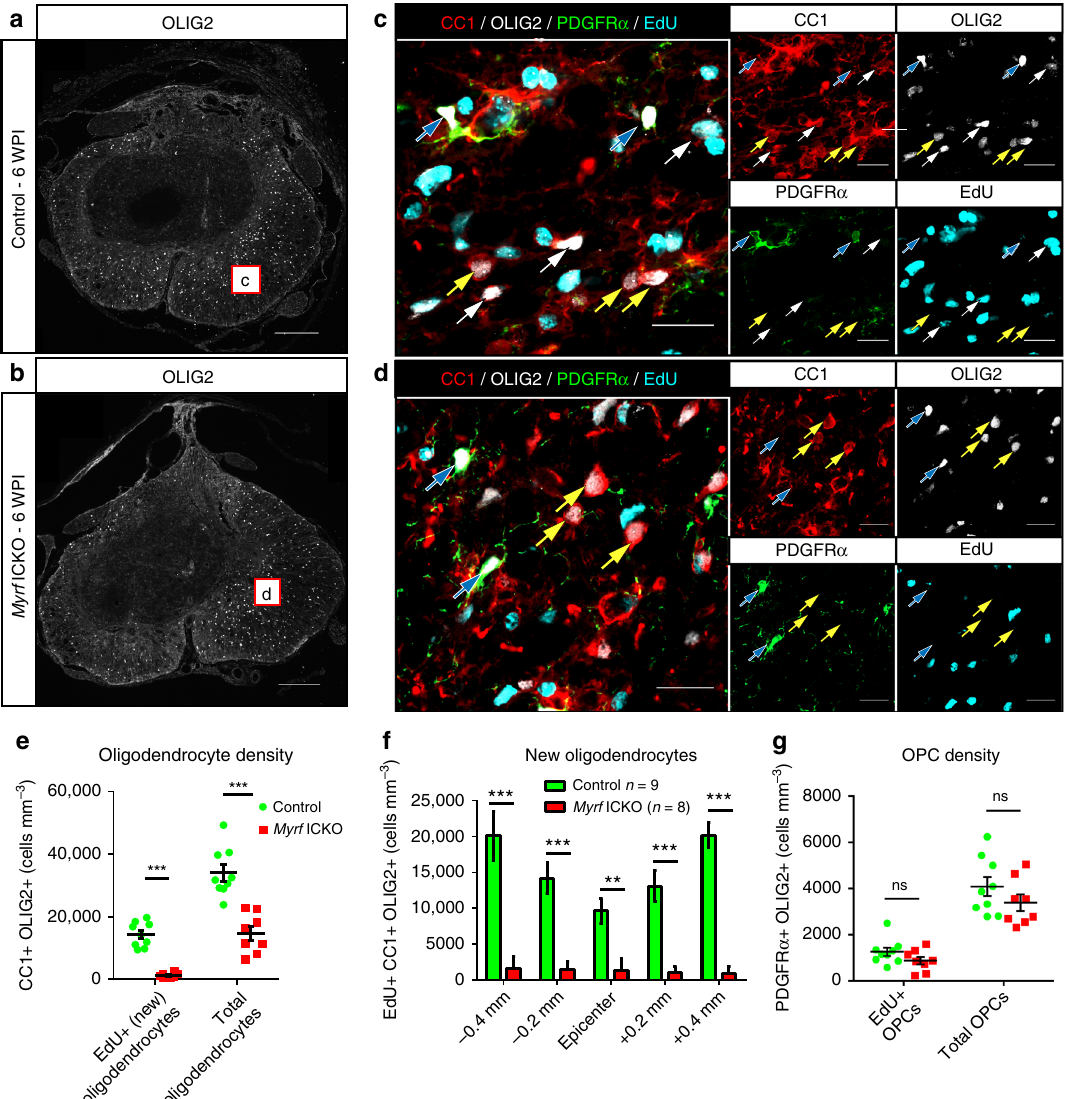
Fig. 2 Myrf ICKO mice generate few new oligodendrocytes in response to SCI. Overview of OLIG2 staining at injury epicenter in a control and b Myrf ICKO mice at six WPI. Boxes are approximate areas where c and d were imaged. c , d Example high magni fi cation representative images of the ventrolateral white matter stained with PDGFR α , OLIG2, CC1, and EdU in control and Myrf ICKO mice. Single channel images are displayed separately on the right. Yellow arrows indicate oligodendrocytes lacking EdU (OLIG2 + CC1 + EdU-negative), which are likely spared oligodendrocytes, while white arrows indicate new oligodendrocytes (OLIG2 + CC1 + EdU + ) and blue arrows indicate OPCs (OLIG2 + PDGFR α + EdU±). There are very few new oligodendrocytes following SCI in Myrf ICKO. e Quanti fi cation demonstrates control mice have a higher density of new oligodendrocytes (CC1 + OLIG2 + EdU + ) ( df = 15, t = 9.224, P < 0.001, Student ’ s t test) and total oligodendrocytes (CC1 + OLIG2 + ) ( df = 15, t = 5.570, P < 0.001, Student ’ s t test) compared to Myrf ICKO animals. f Distribution of newly generated cells at different distances from lesion epicenter (OLIG2 + CC1 + EdU + ). At all distances, control mice have more new oligodendrocytes relative to Myrf ICKO mice (multiple Student ’ s t test with Holm- Š ídák correction, epicenter t = 4.100, P = 0.001, all others distances P < 0.001). g Quanti fi cation of the density of OPCs that have proliferated (PDGFR α + OLIG2 + EdU + ) and total density of OPCs (PDGFR α + Olig2 + ) indicate there is no statistical difference between Myrf ICKO and controls (total OPC density: df = 15, t = 1.535, P = 0.146; proliferative OPC density: df = 15, t